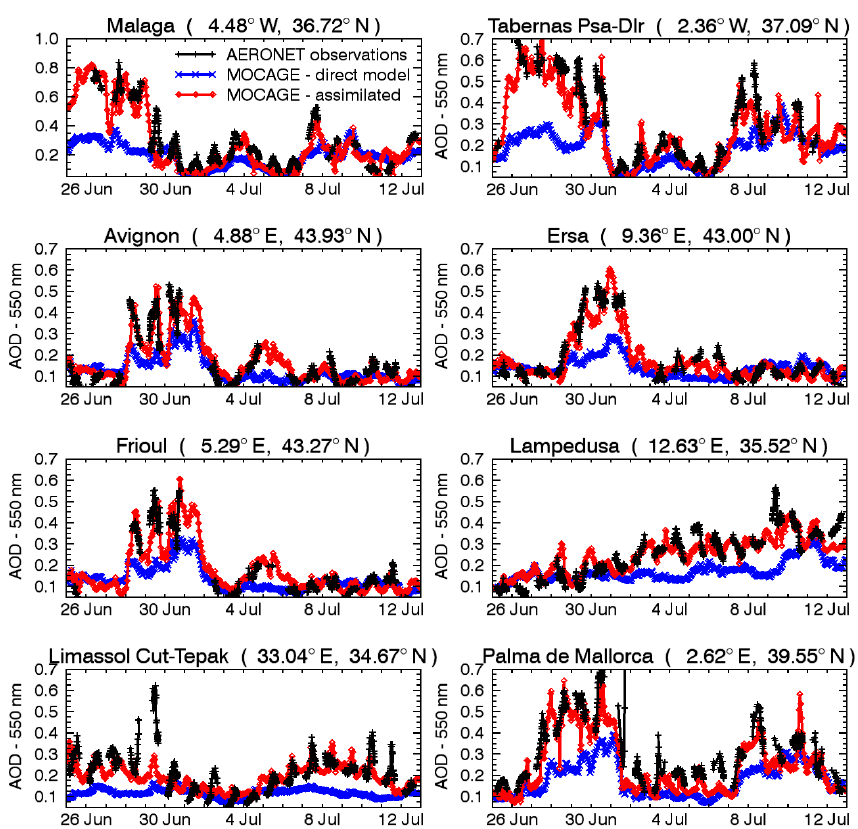
Figure 6. Time series of aerosol optical depth at 550nm of the AERONET data (black line), the direct model (blue line) and the assimilation model run (red line) for the period of the TRAQA campaign from 25 June until 13 July 2012. The presented AERONET data are from eight stations: Malaga (ESP), Tabernas (ESP), Avignon (FRA), Ersa (FRA), Frioul (FRA), Lampedusa (ITA), Limassol (CYP), Palma de Mallorca (ESP). The location of a particular station is marked at the top of each panel. Correlation, bias and root mean square error for both the direct model and the assimilation model run as compared to the AERONET data are given in Table